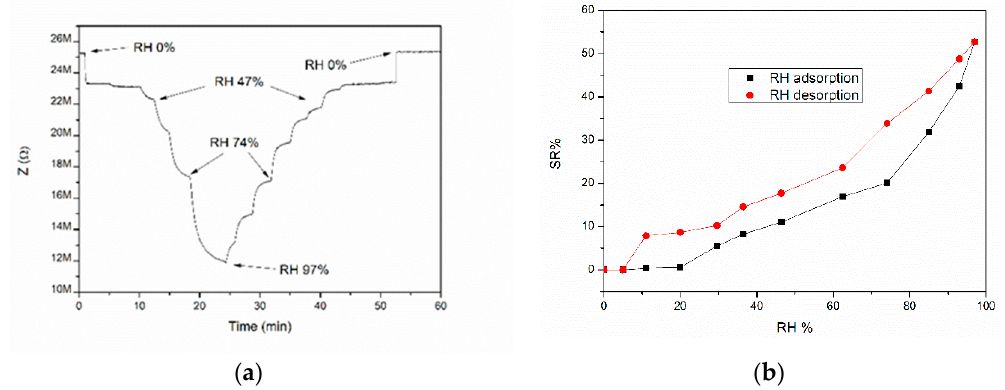
Figure 10. Impedance variation ( a ) and SR% values at different RH% ( b ) for CGB sensor during adsorption and desorption cycle.